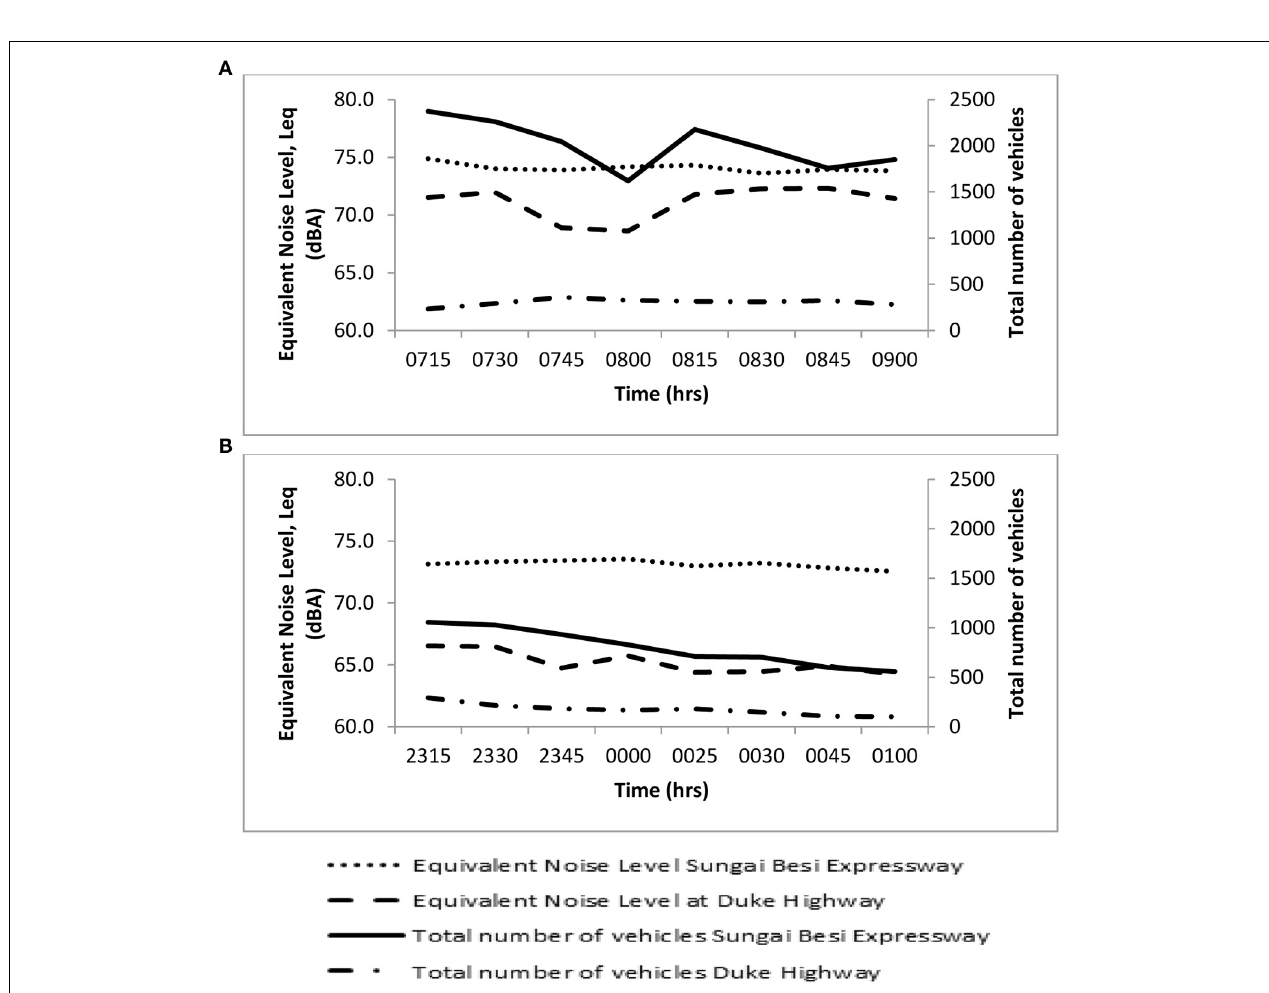
FIGURE 1 | Equivalent noise level (L eq ) between (A) peak hours and (B) off peak hour period at Sungai Besi Expressway, Selangor and Duke Highway, Kuala Lumpur.